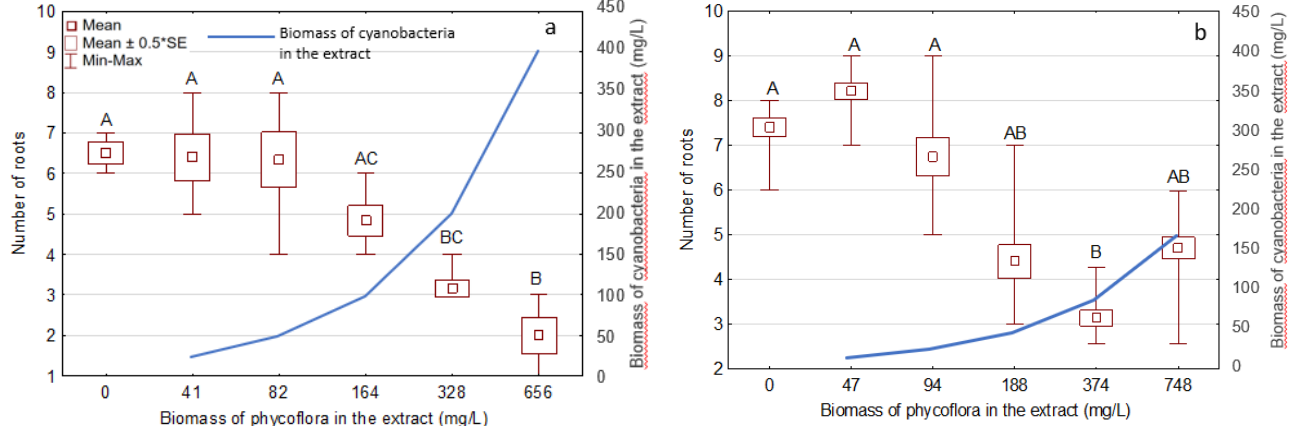
Figure 3. Effect of Phormidium extract ( a ) and Oscillatoria extract ( b ) on the number of roots of S. polyrhiza after 72 h exposure (means ± SE, n = 6, 0 = controls). Different uppercase letters (A, B, C) indicate statistically significant differences between treatments (ANOVA, Tukey’s test, p < 0.05).